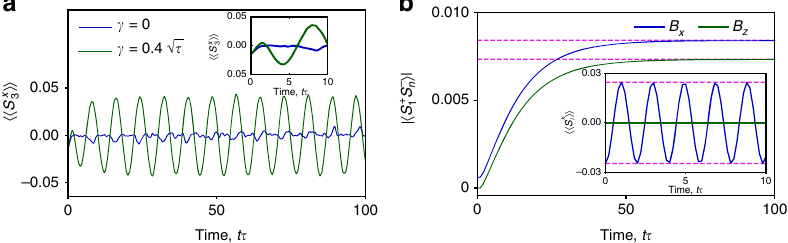
Fig. 2 Dynamics of spin observables in the number-dephased Hubbard model following a quench. a The bulk-averaged fermion spin S x i ð t Þ system sizes M . The evolution starts from the half- fi lled lattice state S x i while all others are polarized along x . A long-time amplitude of 1/6 independent of M is obtained analytically. b Amplitude of the oscillations of h S x ð t Þ S x ð t Þi in the long-time limit for different M and arbitrary i , j . The starting state is the maximally polarized quarter fi lled state with a fermion put on i i þ j every second site. The magenta dashed curve shows the analytical result converging to 1/16 in the limit M ! 1 . c The spectra obtained from the dynamical evolution in a and b for times t 2 ½ 20 ; 100 (cid:3) = τ are strongly peaked around multiples of B as expected in the long-time limit. d Traces of the polarization in the xy -plane starting from the maximally polarized starting state S x i = 9. The solid lines are averages over 2000 trajectories (see Methods). The markers show values from a single realization and the shaded area indicates the range of typical fl uctuations of a realization. All calculations were carried out for B = 0.8 τ , U = τ and γ ¼ 0 : 4